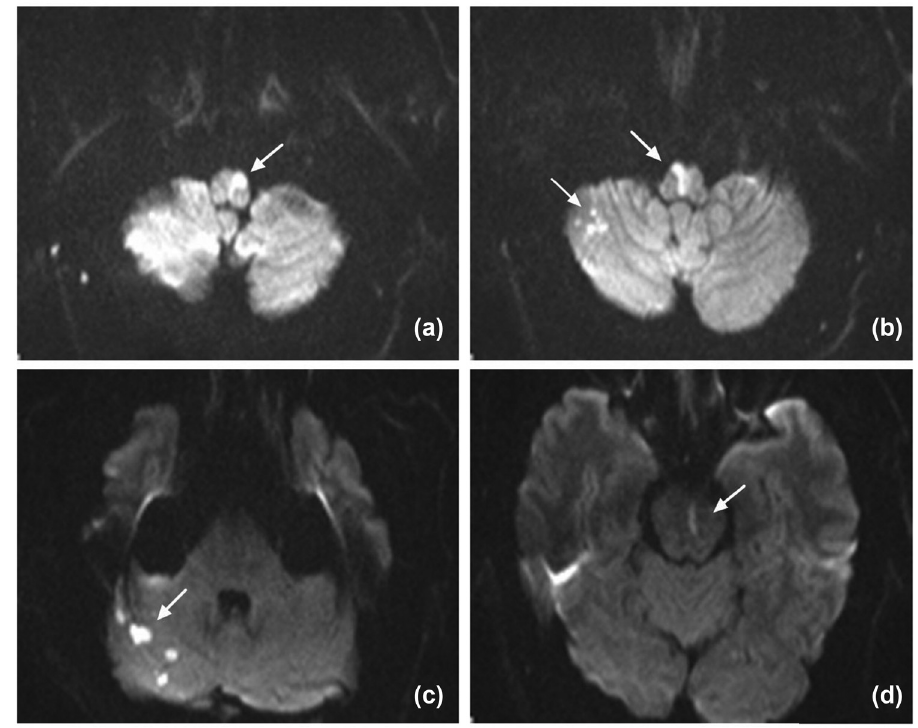
Figure 1: ( Axial DWI imaging ) : ( a and b; arrow ) bilateral medial medullary infarction involves the ventral, middle parts of the medulla oblongata, which were compatible with atypical “ heart appearance. ” ( b and c ) The right cerebellar hemisphere and ( d ) pons also showed high - intensity